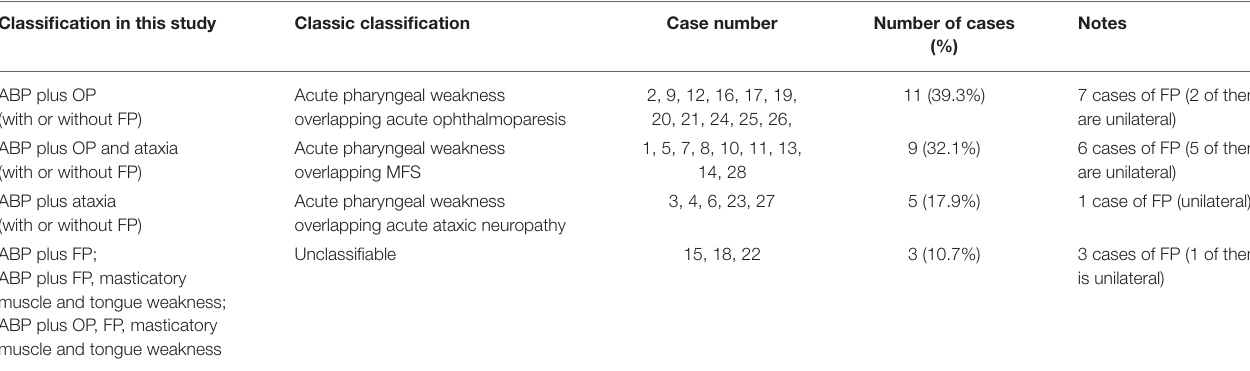
TABLE 3 | Comparison of two classification methods for enrolled patients. Classification in this